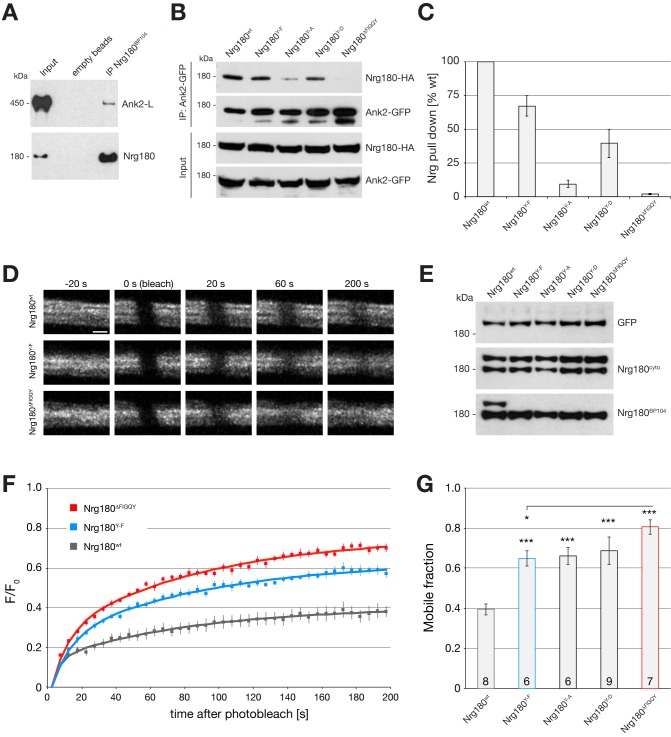
Mutations in the FIGQY–Ankyrin binding motif alter the Nrg–Ank2 interaction and increase Nrg mobility in vivo.(A) Co-immunoprecipition (Co-IP) of Ank2-L from larval brain by Nrg180. IP of Nrg180 using the neuronal-specific antibody NrgBP104 co-precipitates the large Ank2-L isoform (450 kDa) from larval brain extracts. No Ank2-L signal is observed when using empty beads. (B) IP of Nrg180-HA proteins using Ank2-S–GFP from co-transfected S2-cells. Ank2-S pulled down wild-type Nrg180-HA efficiently. Mutations in the FIGQY domain differentially affected binding efficiency. Western blots show IPs and input controls. (C) Quantification of four independent IP experiments demonstrated reduced Ank2 binding due to the specific mutations within the FIGQY motif. (D–G) Fluorescence recovery after photobleaching (FRAP) experiments using GFP-tagged versions of wild-type and mutant forms of Nrg180 at the NMJ. (D) Representative recoveries of FRAP in motoneurons for Nrg180wt, Nrg180Y-F, and Nrg180ΔFIGQY. (E) Equal levels of all GFP-tagged constructs were expressed in motoneurons (ok371–Gal4) in wild-type animals as demonstrated by Western blot analysis. The Nrg180cyto antibody recognizes both wild-type Nrg180 and Nrg180–GFP. In contrast, Nrg180BP104 recognizes endogenous Nrg180 but only the wild-type version of Nrg180–GFP. This indicates that NrgBP104 binds specifically to the Nrg180 FIGQY motif and any alteration of the tyrosine will abolish protein recognition. (F and G) Recovery curves of multiple independent FRAP experiments were fitted to a double exponential curve and used to calculate the mobile fraction of Nrg180. Wild-type Nrg180 recovered to about 40% within the 200 s time frame. The mobility of Nrg180 was significantly increased (more than 1.5×) when the FIGQY motif was mutated (Nrg180Y-F, Nrg180Y-A, Nrg180Y-D). An almost 2-fold increase in mobility was observed after deletion of the Ankyrin-binding motif (Nrg180ΔFIGQY). Numbers in F represent number of independent experiments analyzed. Scale bar in (D) represents 5 µm. Error bars represent SEM.